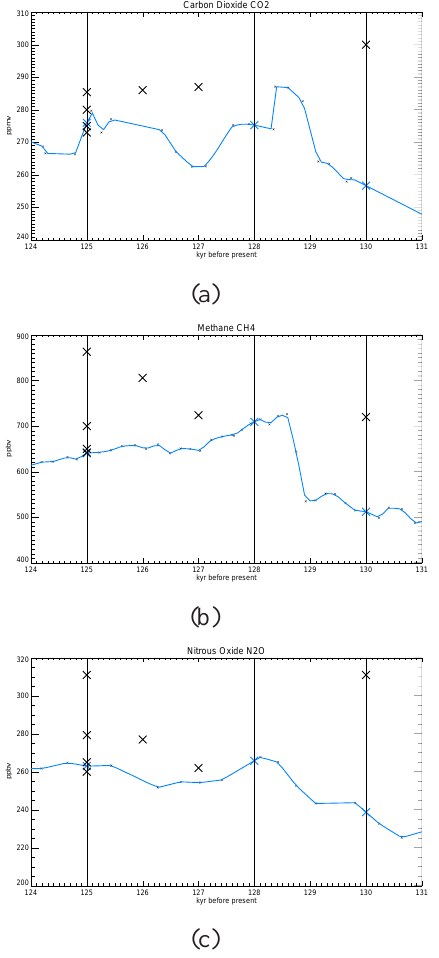
Fig. 2. Atmospheric concentrations of (a) CO 2 , (b) CH 4 and (c) N 2 O through the last interglaciation. Vertical lines show the PMIP-defined snapshots of 125, 128 , and 130ka. Small black crosses show the raw gas concentrations from the Dome C ice core: L¨uthi et al. (2008) for CO 2 (although note that this is a composite record), Loulergue et al. (2008) for CH 4 and Spahni et al. (2005) for N 2 O. Blue line shows this raw data interpolated onto a 100-yr resolution. Large blue crosses show the PMIP3 gas concentrations at the time of the snapshots. Large black crosses show the green- house gas concentrations used by those groups which did not use the PMIP3